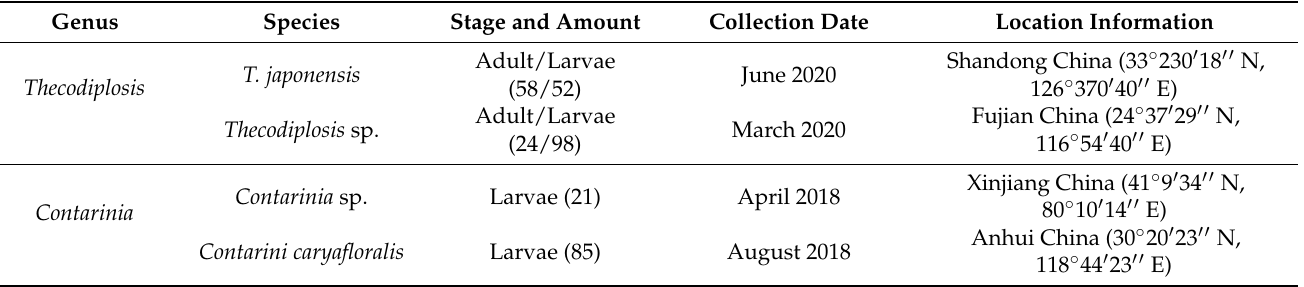
Table 1. Specimens used in LAMP assay and SS-COI PCR to identify T. japonensis from other gall